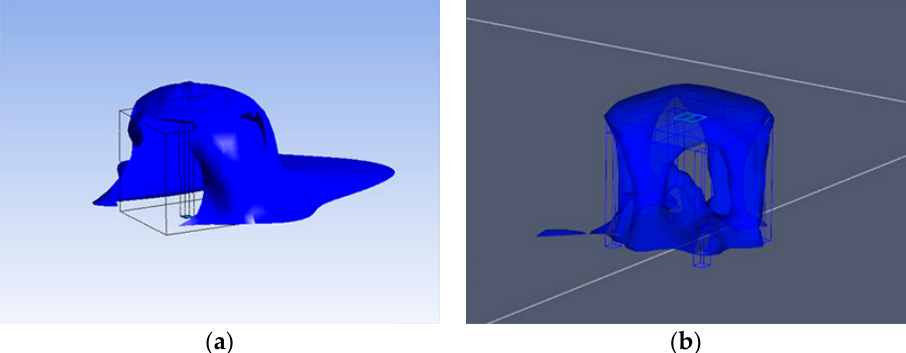
Figure 5. Iso-surface for propane representing 25% concentration of LEL for ( a ) Ansys software and ( b ) FDS.